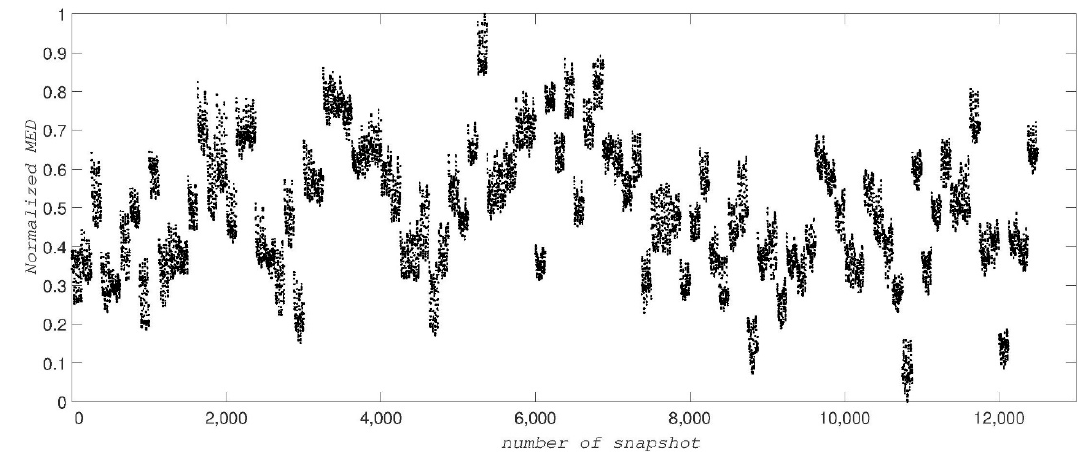
Figure 5. The normalized MED values for 12,500 snapshots of ADK showing 100 islands for the 100 different conformational states.